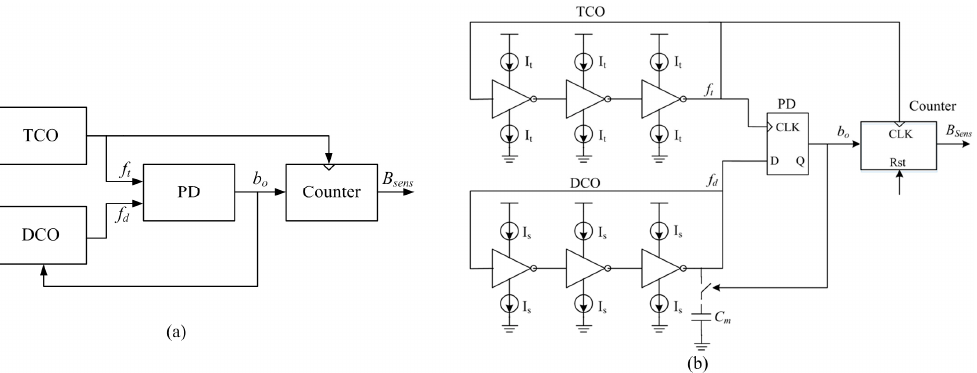
Figure 6. Proposed temperature sensor: ( a ) architecture; and ( b ) schematic.